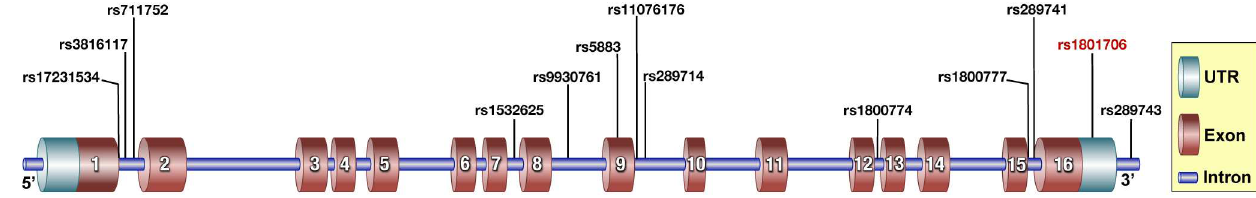
Fig 1. Observed variations and its location in CETP gene.mRNA. ENST00000200676was utilized to represent the physical location of